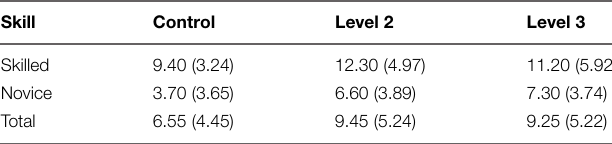
TABLE 2 | Mean and (SD) test performance (successful putts out of 30) as a function of skill and condition.